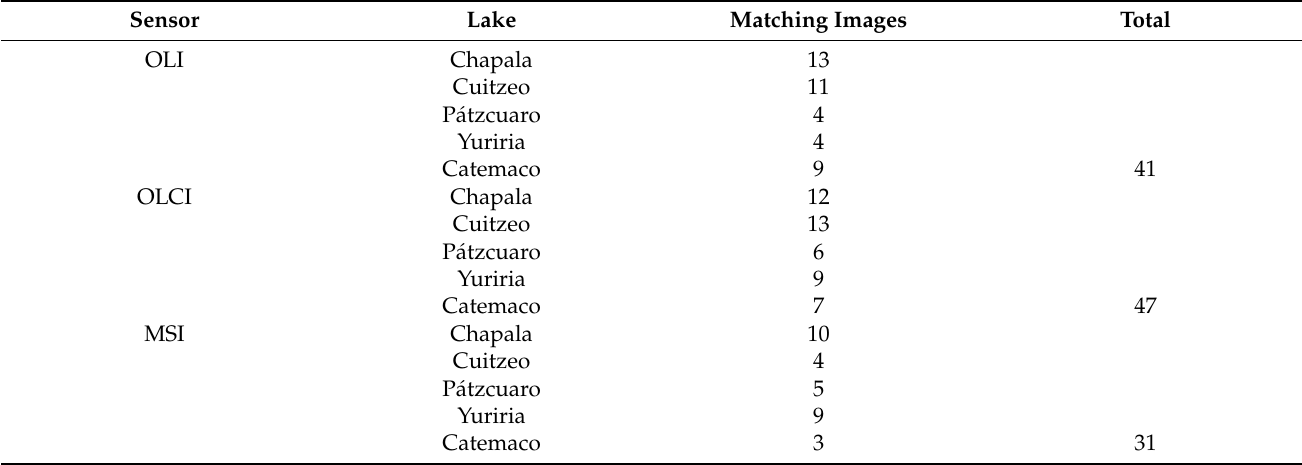
Table A3. Matching satellite acquisitions and RNMCA sampling dates. Complete table with images ID is provided in the complementary